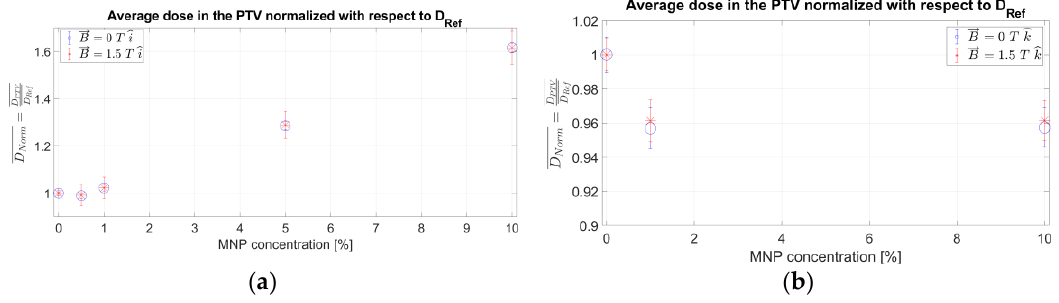
Figure 7. Mean absorbed dose within the PTV target volume, normalized to the reference (no magnetic field, no magnetic FeNP infusion) case, for different FeNP concentrations in absence of external magnetic field and incorporating 1.5 T magnetic field perpendicular ( a ) and parallel ( b ) to the incident X-ray beam.